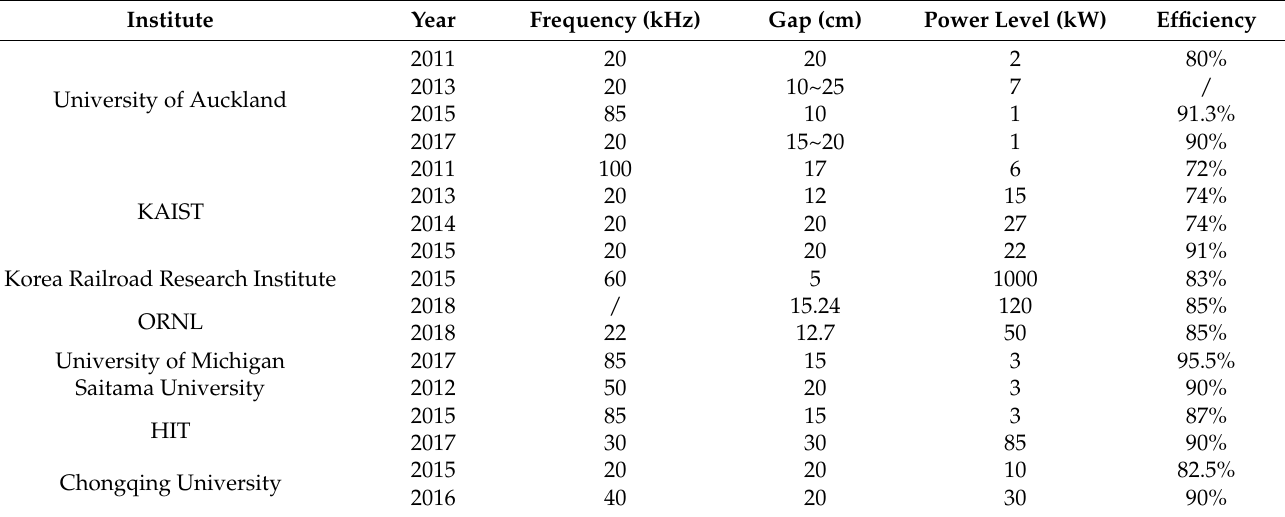
Table 3. Results and parameter indicators of research institutions on WPT